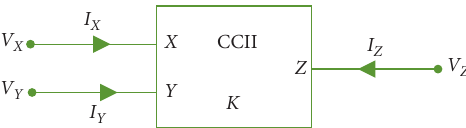
Figure 7: Symbolic representation of